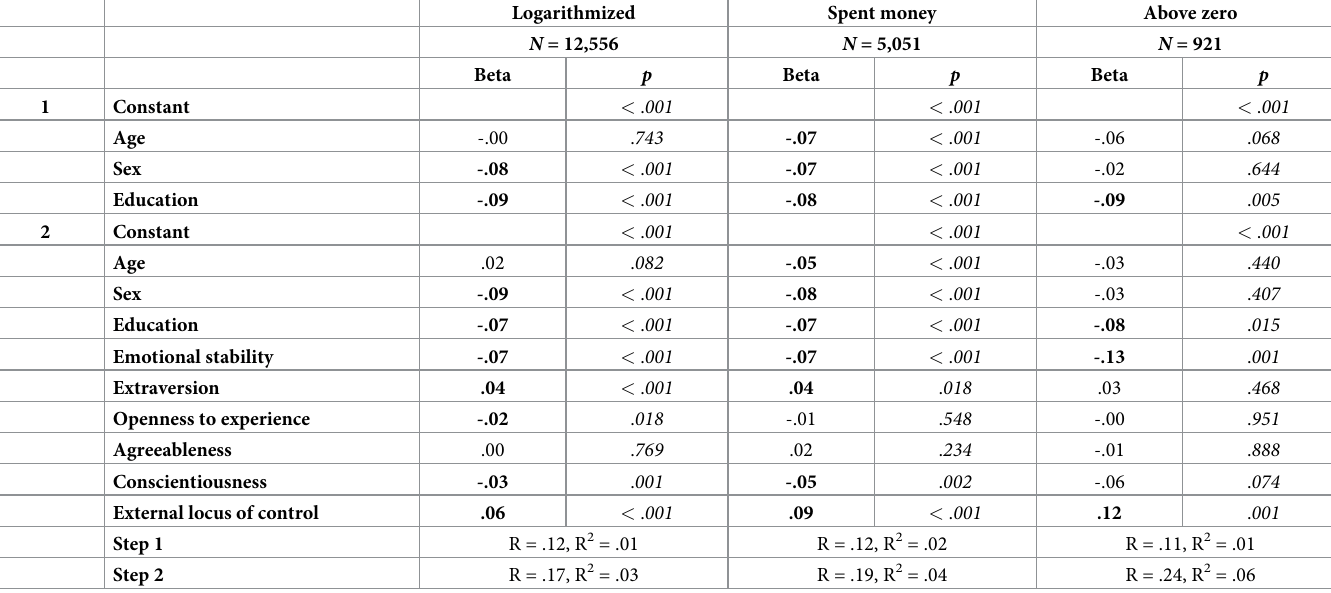
Table 3. Predicting problem gambling from sociodemographic and personality variables using additional